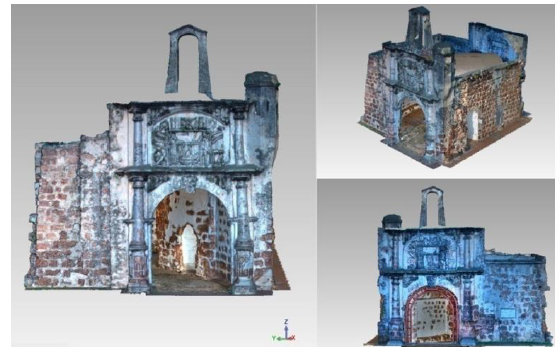
Figure 9. Multiple view of 3D photorealistic model of A'Famosa (intrinsic